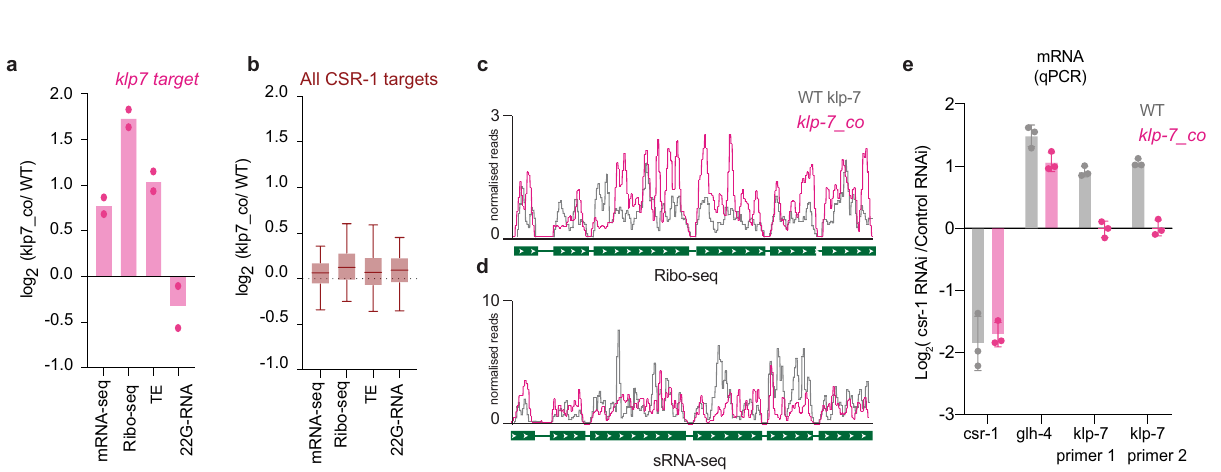
Fig. 5 Highly translated mRNAs and optimal codons negatively correlate with CSR-1 22G-RNA abundance. a Translation ef fi ciency Log 2 (RPF TPM/ mRNA TPM) for CSR-1 targets in WT strain. The distribution for the 22G-RNA in CSR-1 IP for CSR-1 targets with 1 – 50 RPM, 50 – 150 RPM, or ≥ 150 RPM. The sample size n (genes) is indicated in parentheses. The line indicates the median value, the box indicates the fi rst and third quartiles, and the whiskers indicate the 5th and 95th percentiles, excluding outliers. Two-tailed P- values were calculated using Mann – Whitney – Wilcoxon tests. The sample size n (genes) is indicated in parentheses. Data is an average of two biological replicates. b Heat map showing log 2 fold-change in Relative Synonymous Codon Usage (RSCU) for all protein-coding genes categorized by increasing translational ef fi ciency compared to genes showing neutral translational ef fi ciency of 1, as explained in methods. Codons are arranged in order of decreasing RSCU (top to bottom) in the category of log 2 TE ≥ 3. The blue line highlights optimal codons in genes with high TE, and the red line highlights non-optimal codons. c , d Box-plot showing the copy numbers for tRNAs for optimal or non-optimal codons ( c ), and the TPMs for tRNAs from the GRO-seq dataset for WT strain at the late l4 larval stage (44 h) for optimal or non-optimal codons ( d ). The line indicates the median value, the box indicates the fi rst and third quartiles, and the whiskers indicate the 5th and 95th percentiles, excluding outliers. Two-tailed P -values were calculated using Mann – Whitney – Wilcoxon tests. Two biological replicates. For codons with missing cognate tRNA, values have been adjusted by considering tRNA copy numbers and TPMs for tRNA recognizing these codons by wobble base pairing 90 . (see Supplementary Fig. 8b, c for non-adjusted values). e Heatmap similar to b showing log 2 fold-change in relative synonymous codon usage for all CSR-1 targets (1 – 50, 50 – 150, and ≥ 150 RPM of 22G-RNA) compared to genes showing neutral translational ef fi ciency as explained in methods. “ * ” marks over-used non-optimal codons by CSR-1 targets and “ # ” marks under-used optimal codons. f Plot showing the z -score for the read-density for the of 5 ʹ terminus of 22G-RNAs for CSR-1 targets relative to the start of 29-nt long Ribosomal protected fragments (RPF) with either optimal or non-optimal codons at their P and A site. The scheme shows possible initiation of 22G-RNA biogenesis after a slicing event downstream of RPF with non-optimal codons at the A and P sites. Source data are provided as a Source Data fi le.